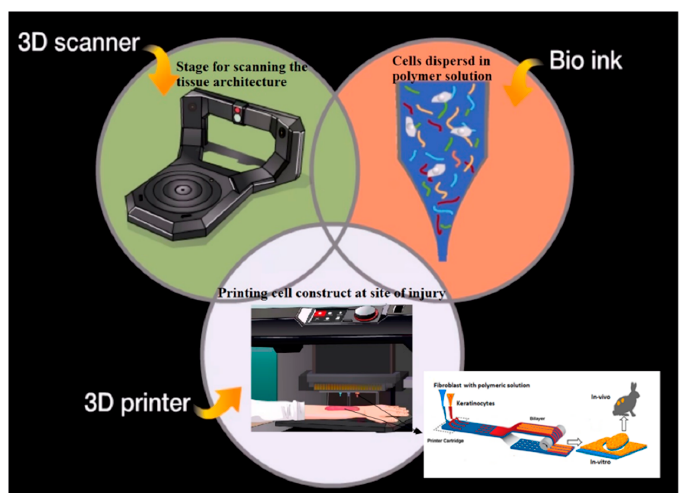
Figure 2. This diagram shows how the PrintAlive Bioprinter works for skin regeneration. Fibroblasts and keratinocytes two types of characteristic skin cells are kept in separate channels and spurted out of the 3D printer to custom an organized, multi-layer gel modified from